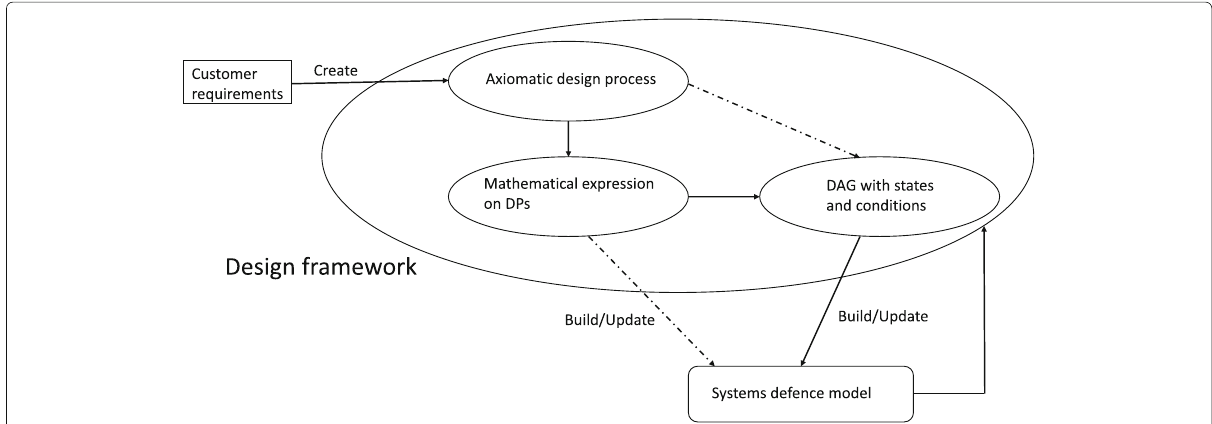
Fig. 3 High-level overview of our design-level analysis for obtaining invariant